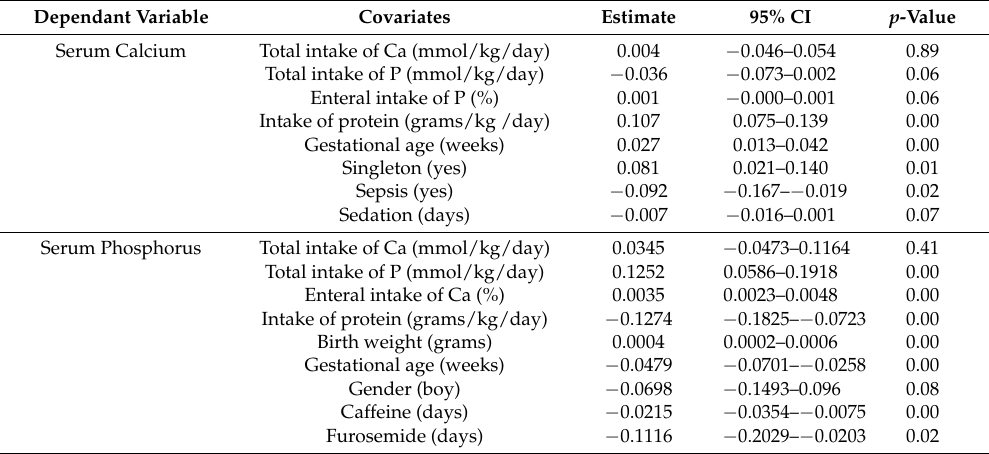
Mixed Model analysis: Effect of nutritional intake and clinical characteristics on biochemical